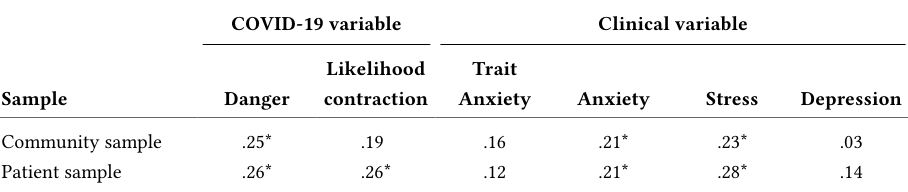
Associations Between Direct Increase of Anxiety in Public Situations and COVID-19 Variables, Clinical, and Demographic Data